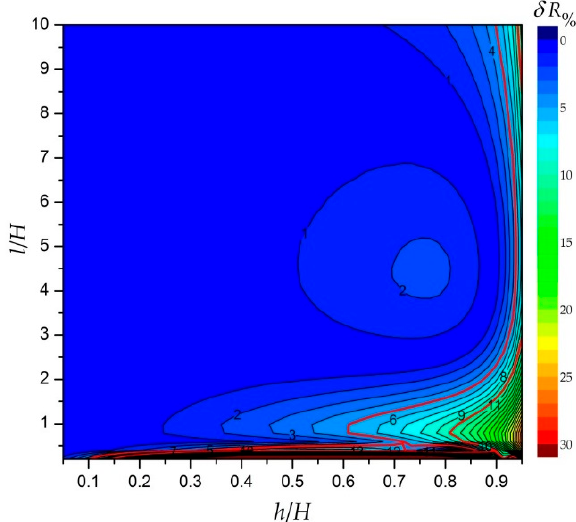
~ Figure 13. Percentage deviation between the resistance (cid:101) R calculated from Formula (36) for the corrected Figure 13. Percentage deviation between the resistance R calculated from formula (36) for the defect length according to Formula (51) and the resistance R calculated corrected defect length according to formula (51) and the resistance R calculated numerically.